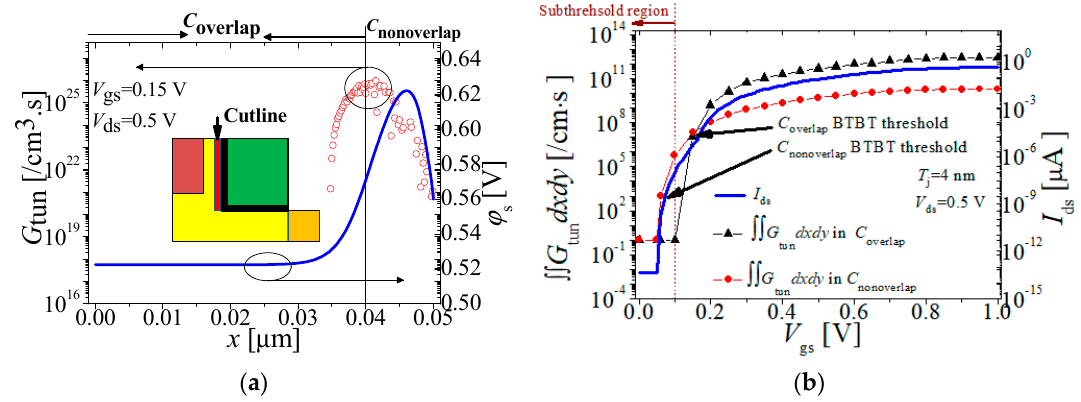
Figure 2. ( a ) G tun along the surface of C overlap and C nonoverlap (left axis), and φ s along the channel (right axis) at V gs = 0.15 V and V ds = 0.5 V. ( b ) Integrated band-to-band tunneling (BTBT) tunneling rates in C overlap (black triangles) and C nonoverlap (red circles) as a function of V gs (left axis), and I ds – V gs characteristics of LTFET (right-axis). BTBT threshold voltages for C overlap and C nonoverlap are indicated by arrows.